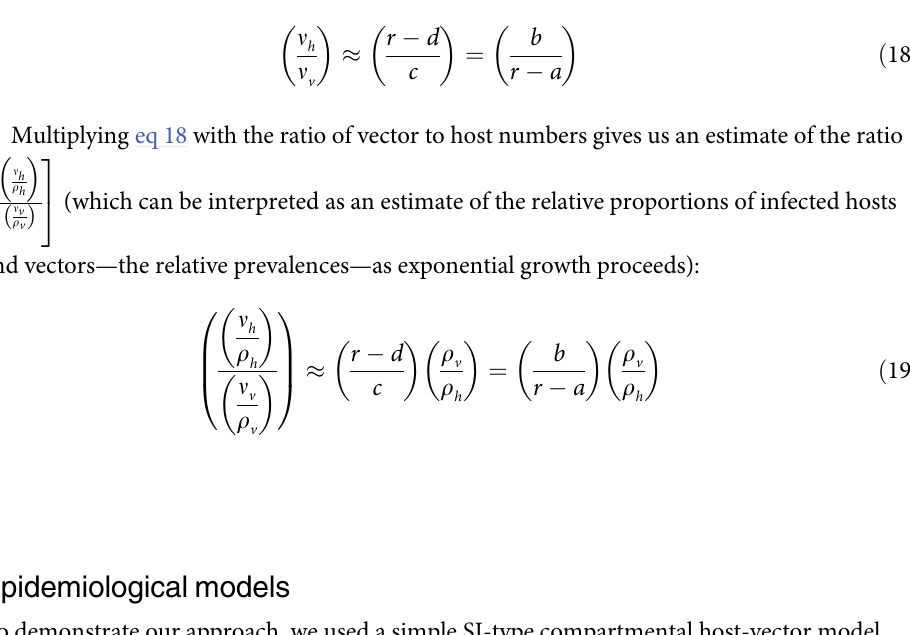
Table 1. Parametervalues used in the estimation of the transmission parameters ( β ) for the two models in the current study. Par Interpretation T Duration of each visit (h) 5 Rate of host visits by vector 1 1 Rate of acquisition by vectors Rate of host inoculation 0.05 0.2 (cid:17) , where κ refers to the receiving group. Most estimates are taken from [29, 37] for HLB and [38, 39] for tristeza. The duration of feeding per visit for the HLB model was taken from [40] and for the tristeza model was adjusted according to the total efficiency of CTV transmission described in [41]. All rates ( ϕ , b v , b h ) are per